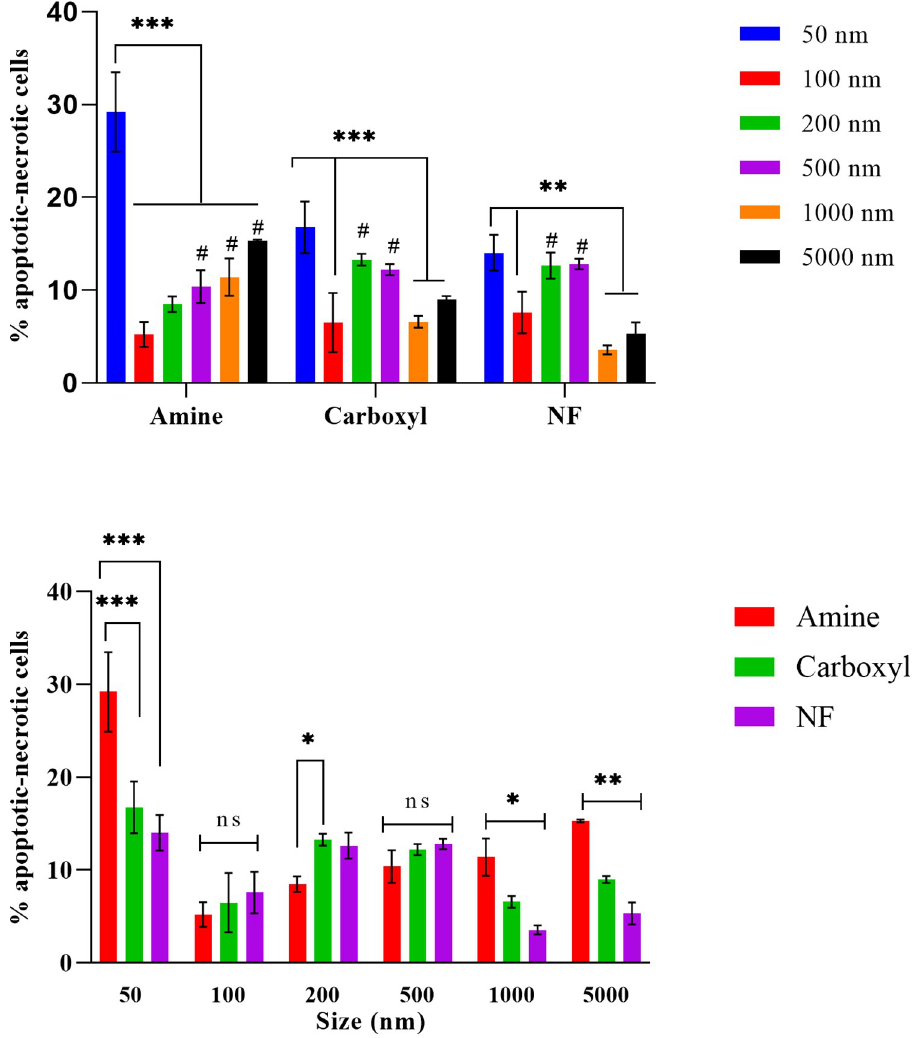
Fig 5. Capability of PS particles in inducing apoptosis-necrosis in SNU-1 cells. Cells were treated for 4 h with 100 μ g/mL aminated, carboxylated or NF particles of sizes 50–5000 nm and stained with Annexin V-PI dyes. Plot shows percentage of annexin V-PI positive cells in late apoptosis-necrosis stage. Data compared with respect to surface functionalization (A) or particle size (B). All data represented as mean ± S.D. (n = 4). Statistically significant difference is represented by � , �� and ��� at p < 0.05, 0.01 and 0.0001, respectively and between 100 nm compared to same surface functionalized larger sized particles by # (p < 0.05); ns represents no significant